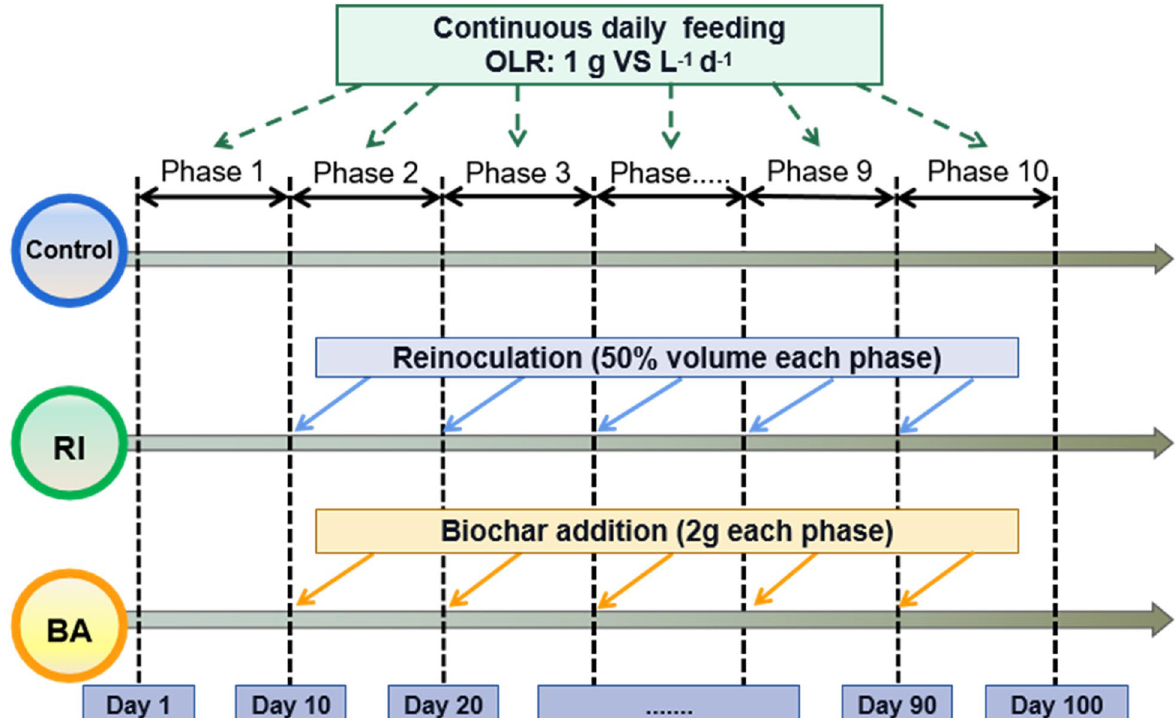
Fig. 1 Graphical representation of operating conditions and experimental